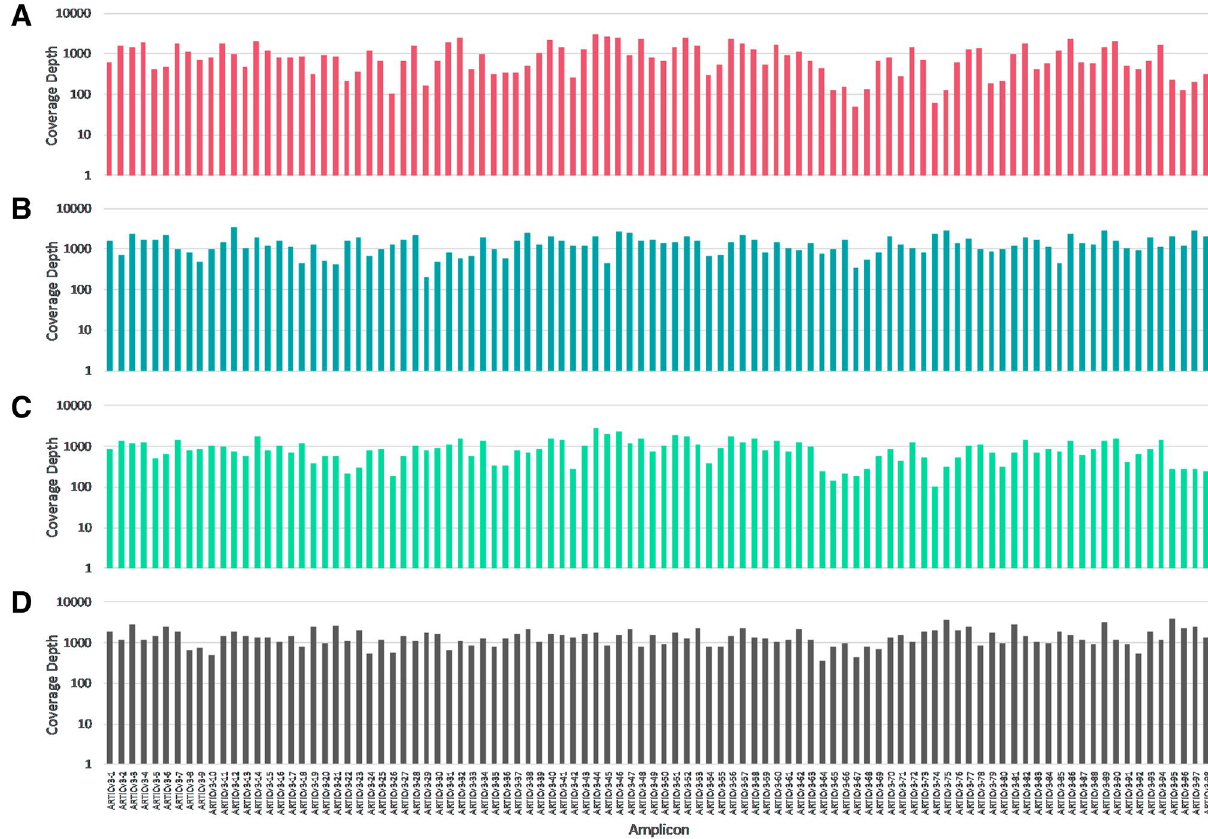
Figure 2. Comparison of amplicon coverage balance. A bar plot depicting the average sequencing depth of the amplicons ( A ) using equimolar primer pools, low performing amplicons were observed; ( C ) optimized modified primer pools, coverage of low performing amplicons was improved; ( B , D ) ARTIC v3 standard primers with even coverage. A same clinical sample set was used for plot ( A ) and ( B ) (Ct 24, n = 11); and ( C ) and ( D ) (Ct 24, n = 5). All samples were normalized to 200,000 mapped reads for